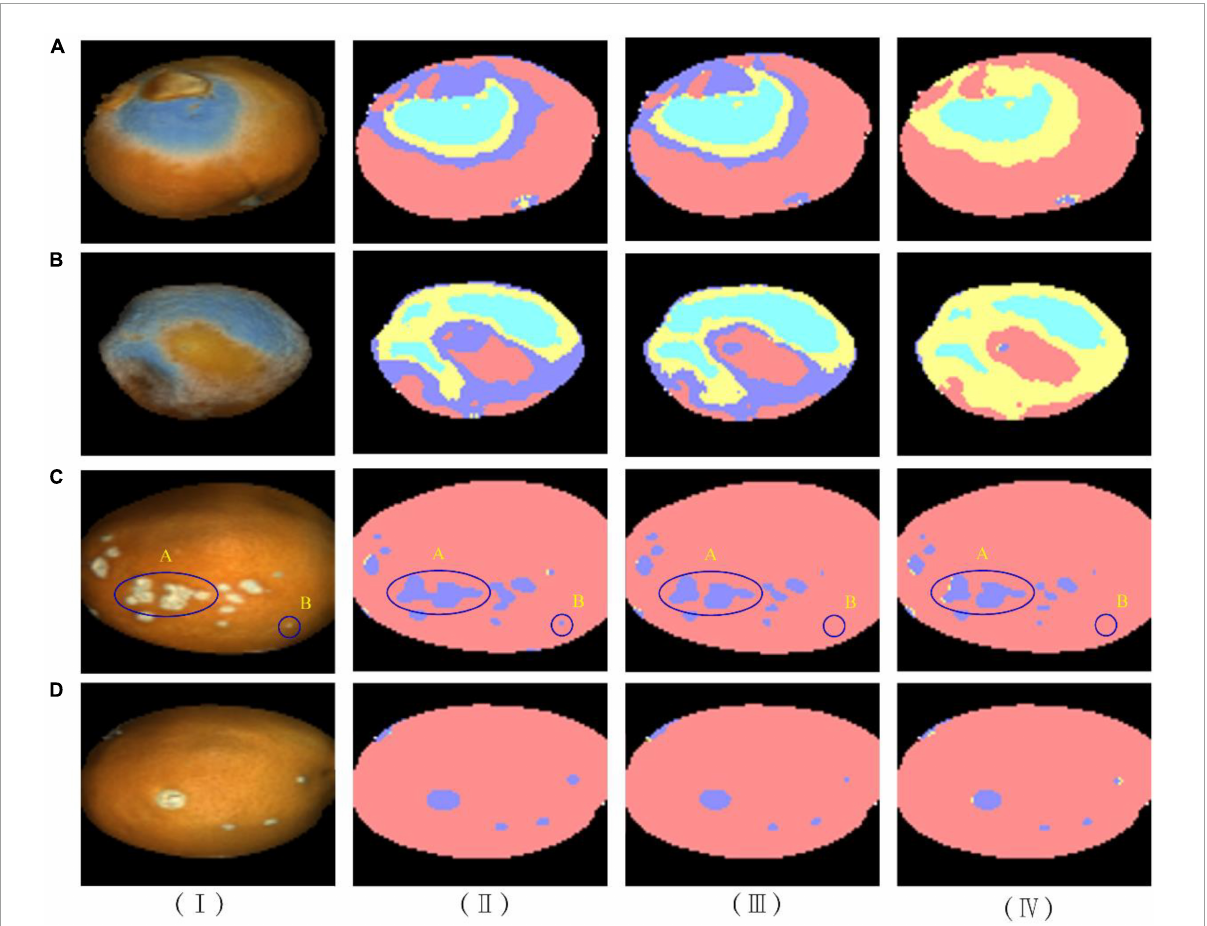
FIGURE11 Result of the three LSTM models for four typical samples. (I) Sample hyperspectral images and corresponding images for models (II) LSTM01, (III) LSTM02, (IV)